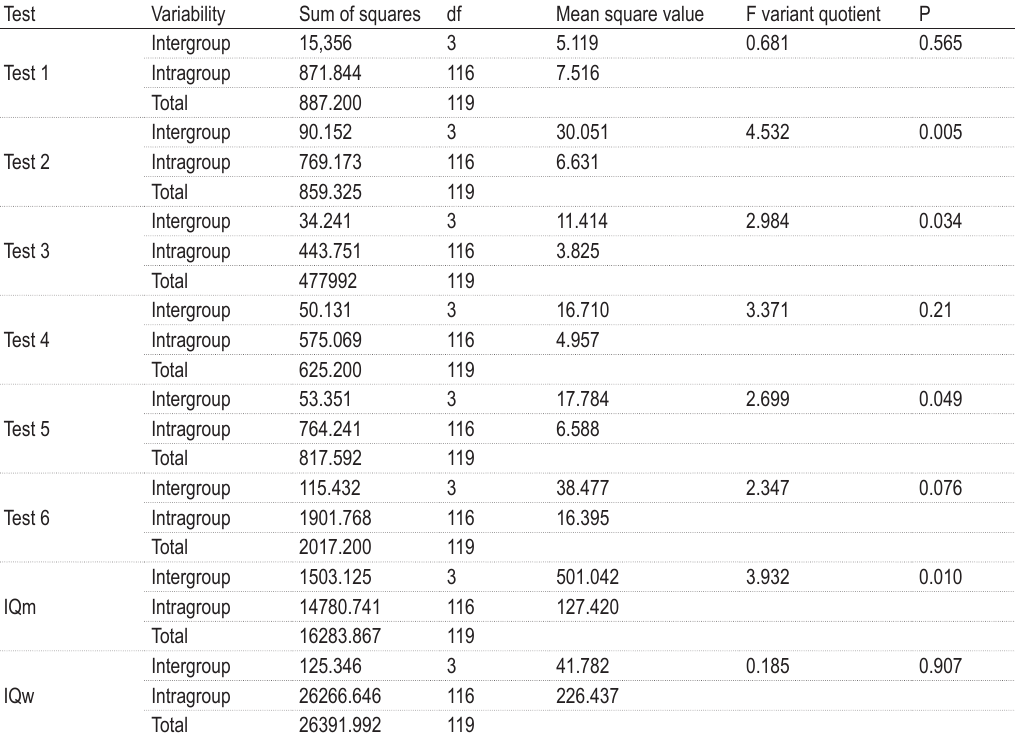
TABLE 2. ANOVA (analysis of variance) - statistical analysis of intergroup, intragroup and total variability in verbal and nonverbal intelligence